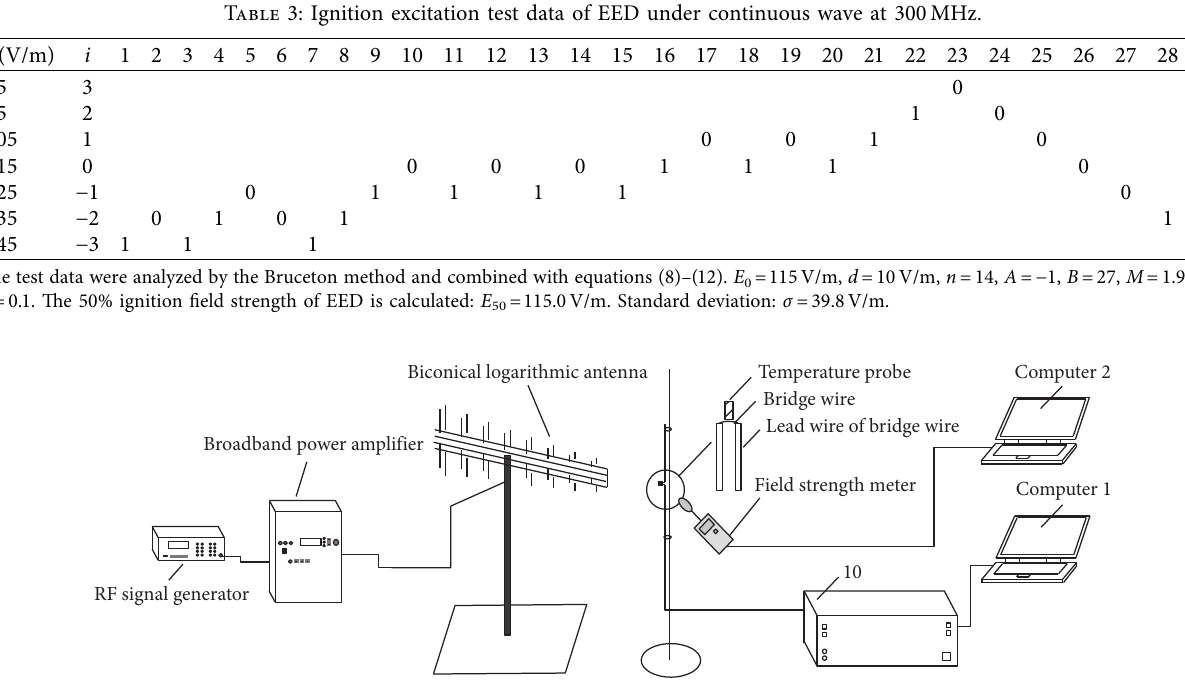
Table 3: Ignition excitation test data of EED under continuous wave at 300MHz.